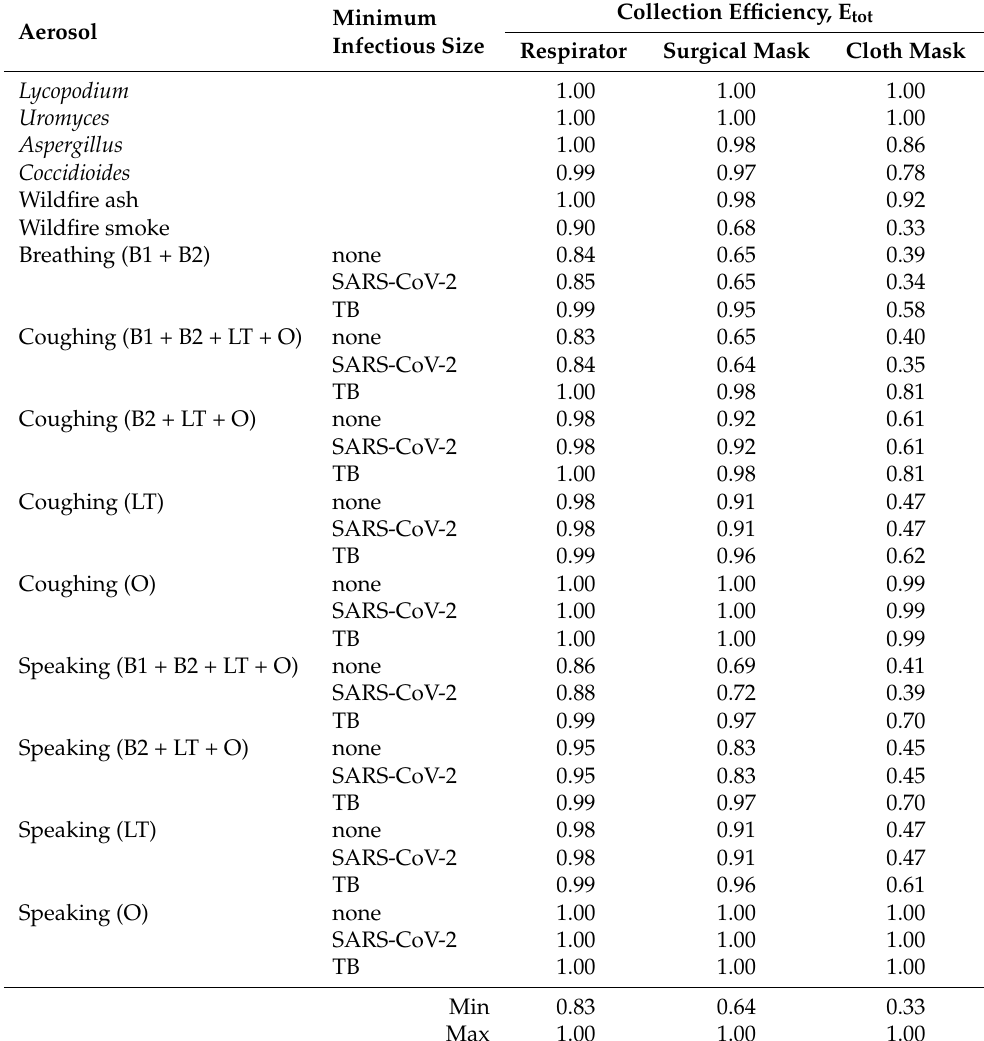
Table 2. Total respirable particle collection efficiencies predicted for different aerosol types. Human- emitted particles were modeled with three different minimum infectious sizes corresponding